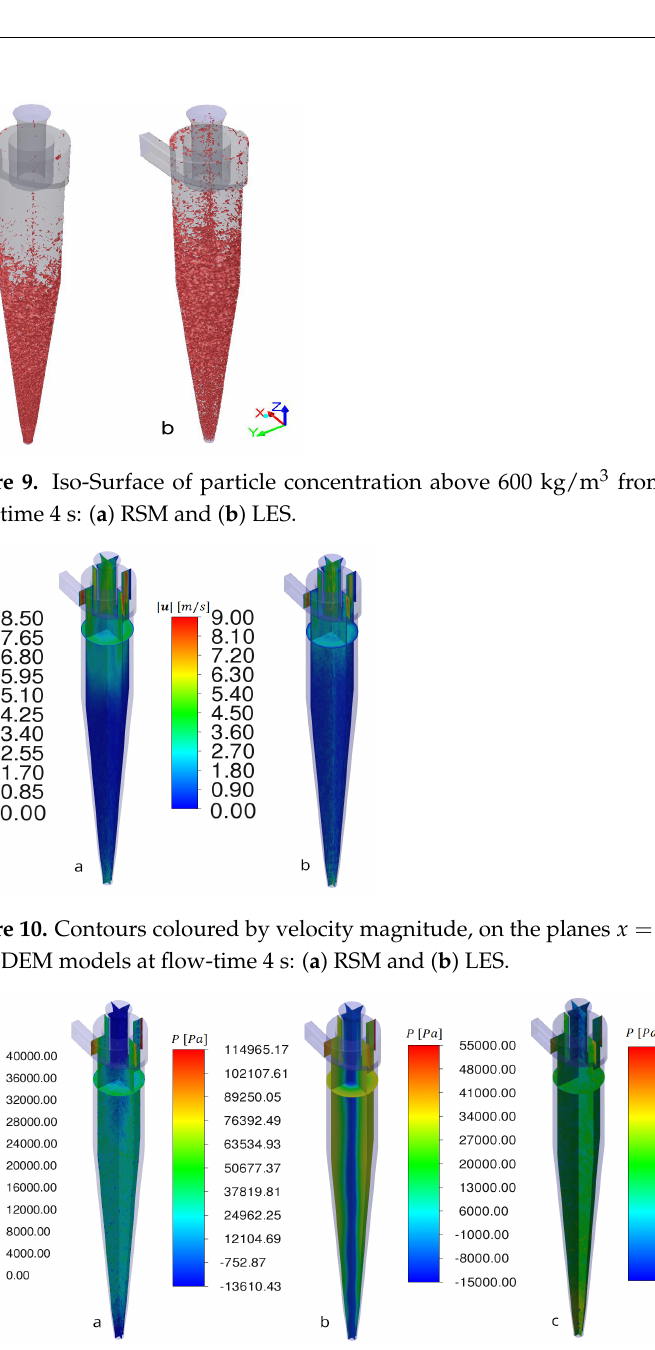
Figure 11. Contours coloured by static pressure, on the planes x = 0, y = 0, and z = 0 from the VOF-DEM models at flow-time 4 s and the VOF models at flow-time 2 s: ( a ) VOF-DEM RSM, ( b ) VOF RSM, ( c ) VOF-DEM LES, and ( d ) VOF